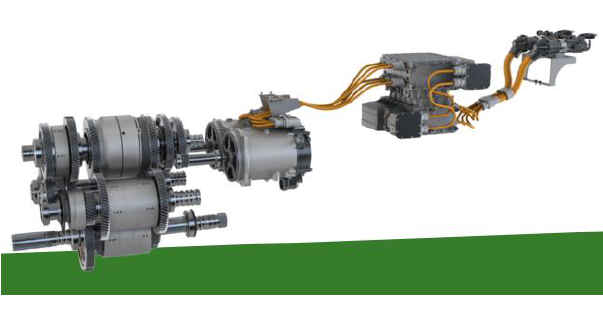
Fig. 20. John Deere eAutoPowr transmission [34]